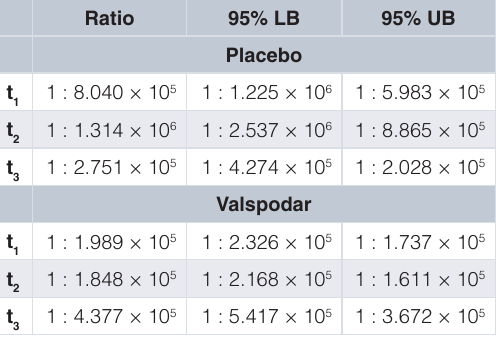
Table 4. Changes in proportion of LPCs in peripheral blood 1 .